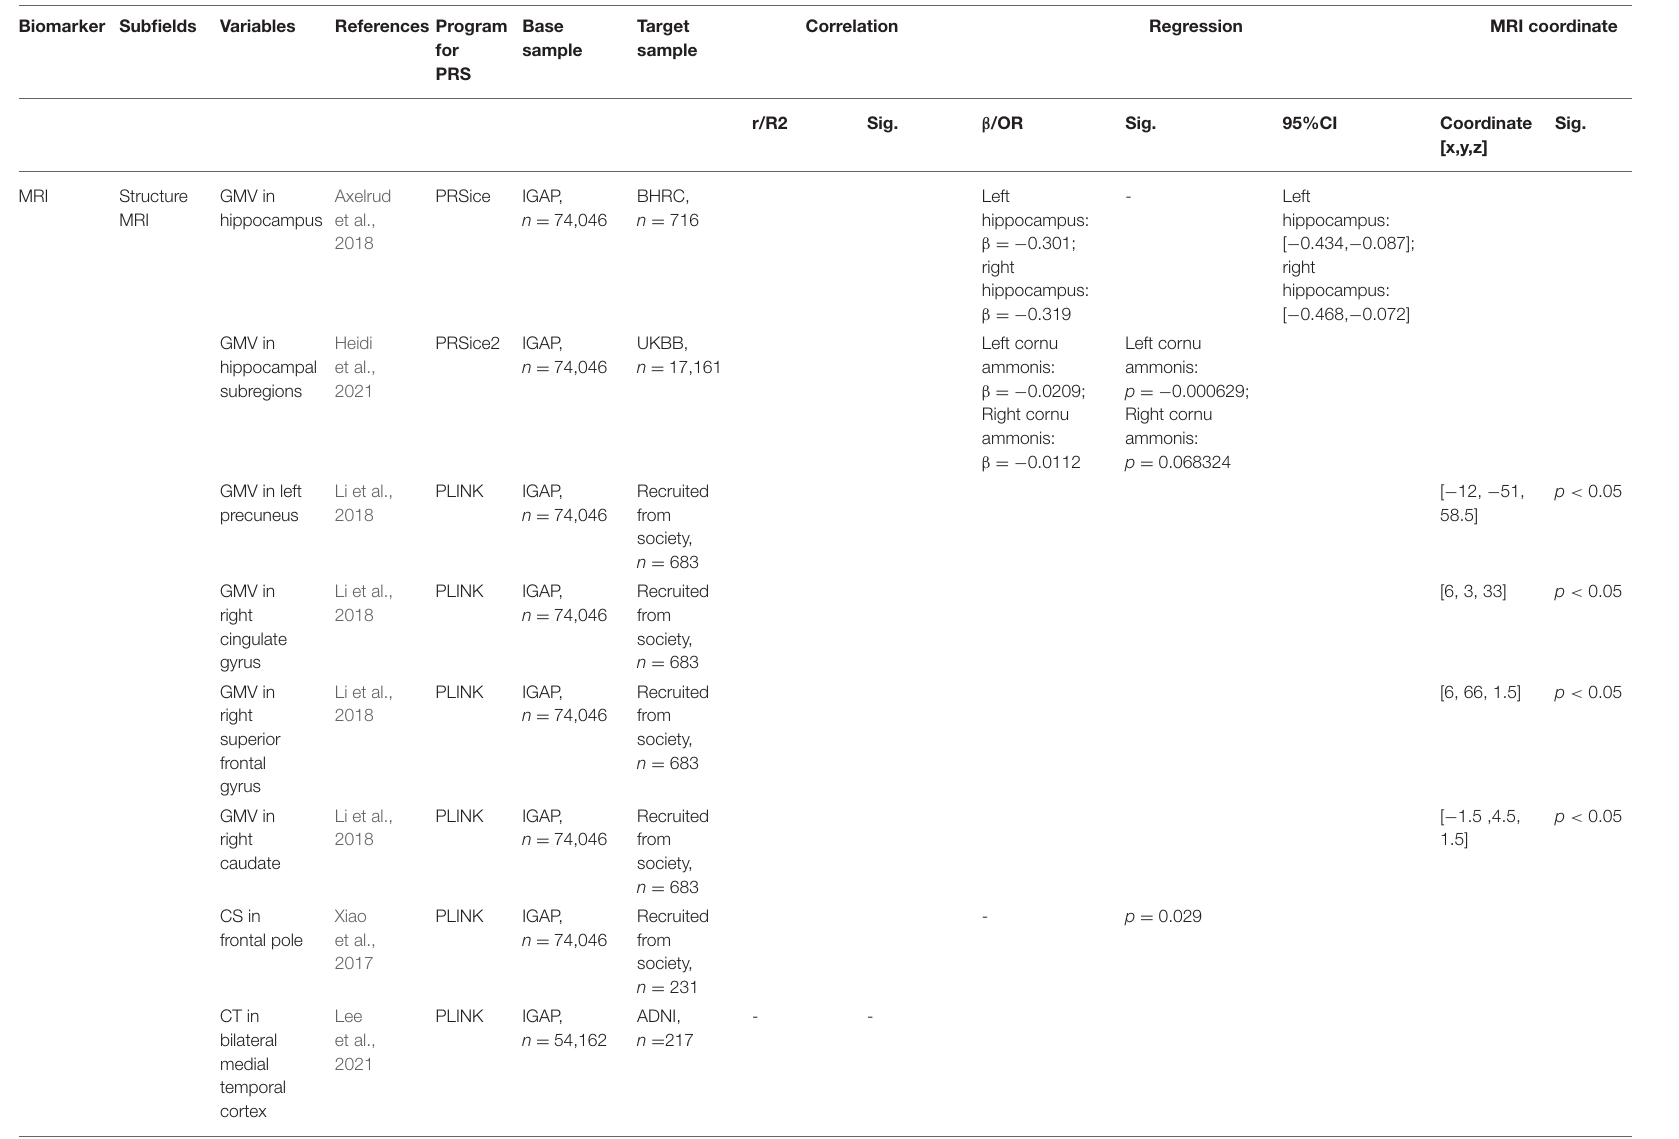
TABLE 1 | The work progress in the associations of AD-PRS with multiple biomarkers. Biomarker Subfields